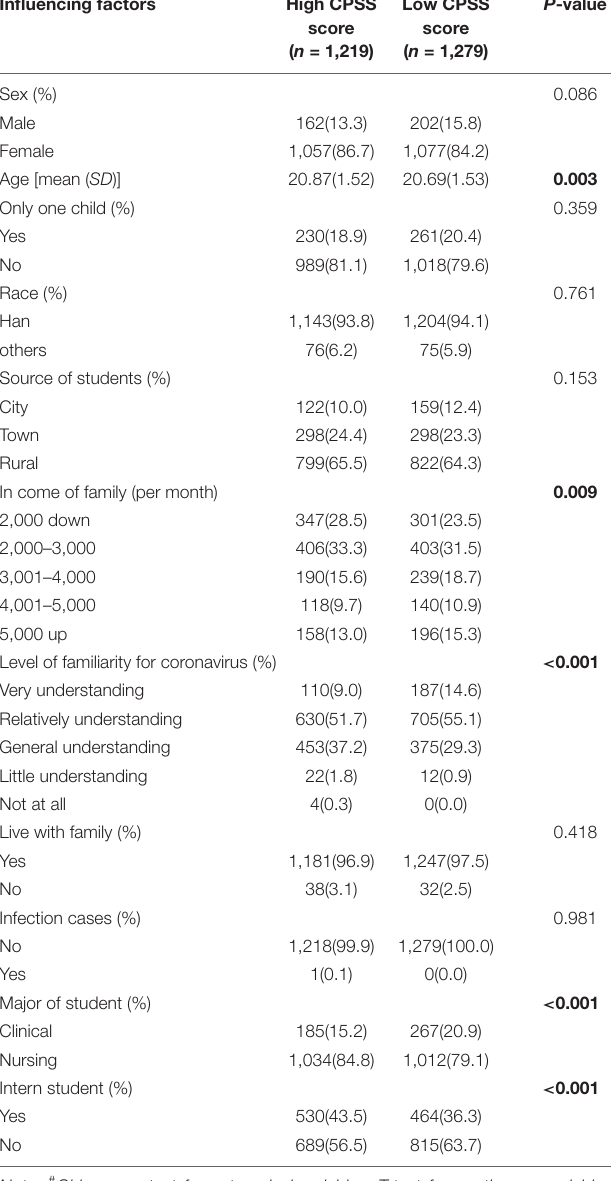
TABLE 2 | The relationship of influencing factors with CPSS score (high vs. low) in medical students. Influencing